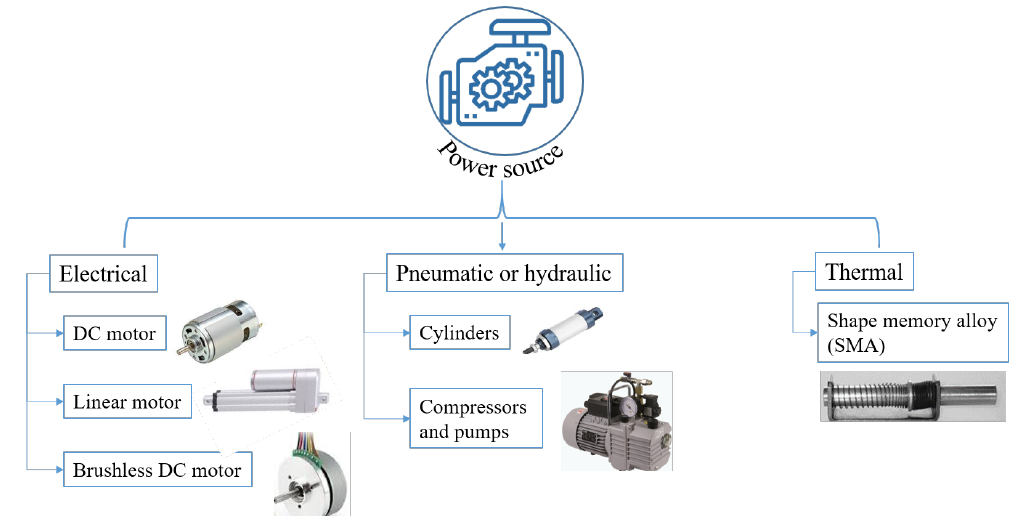
Figure 21. Different types of power source adopted in different